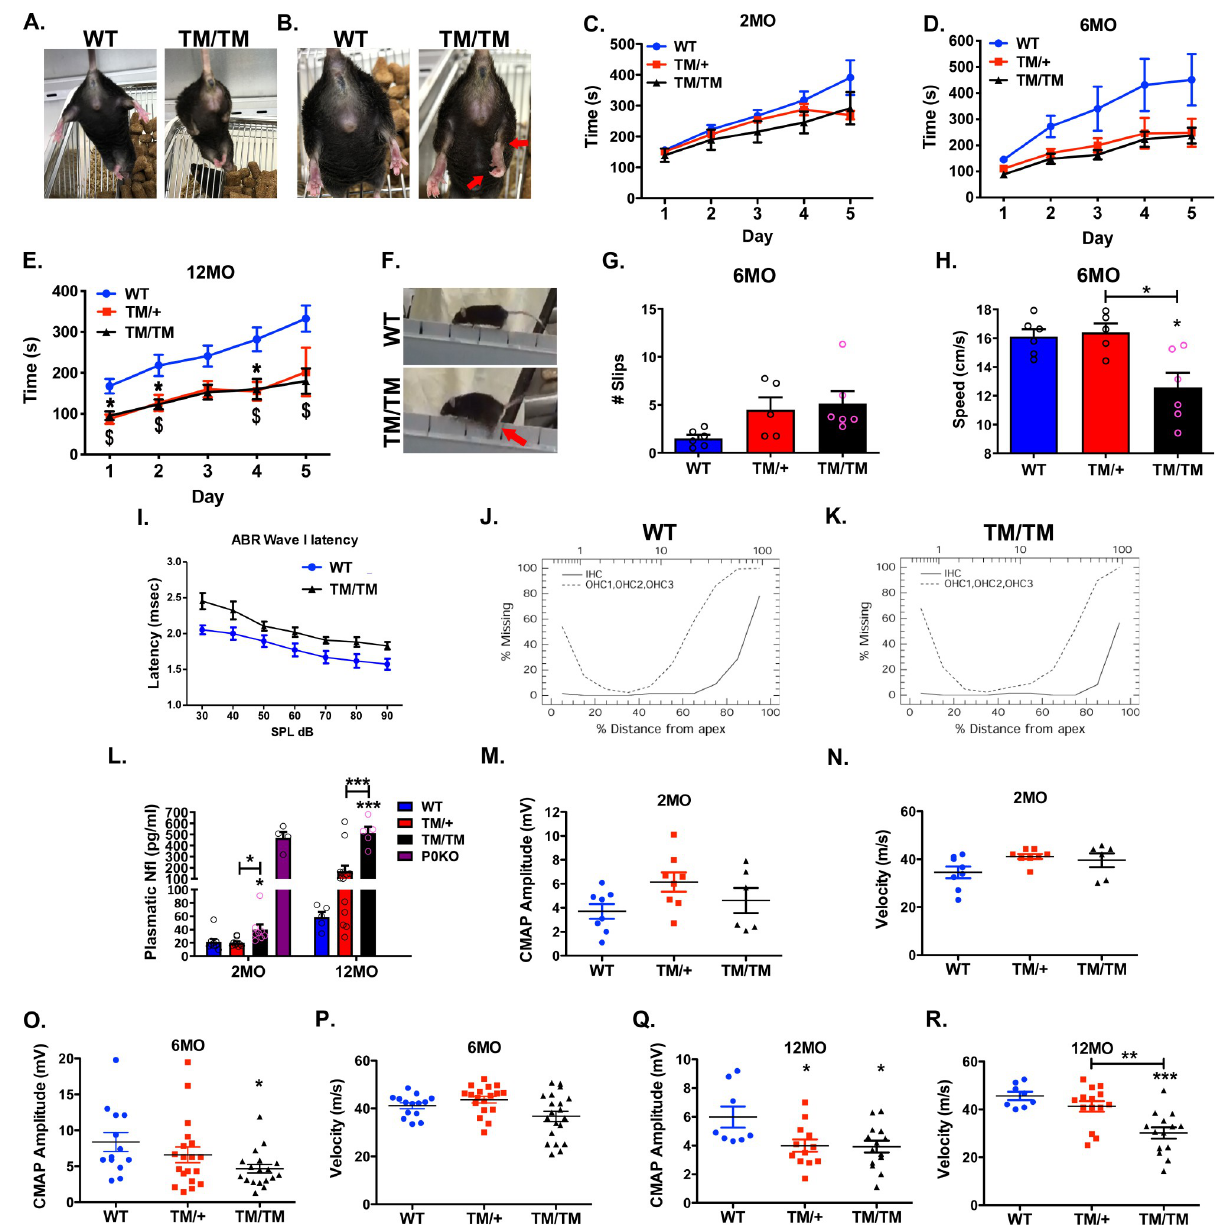
Fig 1. Clinical impairments in Mpz T124M mice. ( A and B ) External signs of neuropathy in 12-month-old Mpz T124M/T124M (TM/TM) mice. ( A ) Representative picture of clasping behavior. ( B ) Clawed hind paws and Achilles’ tendon retraction are indicated by arrows. ( C to G ) Locomotion is impaired in Mpz T124M mice. Accelerating rotarod test at 2 ( C ), 6 ( D ), and 12 ( E ) months of age. No differences were observed at 2 months of age. Compared to that of wild-type (WT) mice, the performance of Mpz T124M mice was worse at 6 months of age and significantly altered at 12. n (animals) � 4 per genotype. Two-way ANOVA [2 month old: Time: F (1.840, 38.64) = 30.54; P < 0.0001, Genotype F (2, 21) = 2.177; P = 0.1382; 6 month old: Time: F (1.723, 43.06) = 19.55, P < 0.0001; Genotype: F (2, 25) = 4.412; P = 0.0228; 12 month old: Time: F (1.291, 23.24) = 11.51; P = 0.0013; Genotype: F (2, 18) = 4.590; P = 0.0245] with Tuckey’s post hoc . � p < 0 . 05 : significant difference between WT and Mpz T124M/+ (TM/+); $ p < 0 . 05 : significant difference between WT and Mpz T124M/T124M . ( F to H ) Beam walking test at 6 months of age. ( F ) Representative pictures of beam walking test for WT and Mpz T124M/T124M mice. Arrow indicates a slip. Quantification of slips ( G ) and speed ( H ). n (animals) � 5 per genotype. One-way ANOVA [Slip: F (2, 14) = 3.430; P = 0.0613; Speed: F (2, 14) = 7.839; P = 0.0052]. ( I to K ) Auditory neuropathy in Mpz T124M mice. ( I ) ABR wave I latency measurements in WT and Mpz T124M/T124M mice at 11 months of age. Cochleograms of WT ( J ) and Mpz T124M/T124M ( K ) mice at 12 months of age. n (animals) � 4 per genotype. ( L ) Plasmatic neurofilament light (Nfl) concentrations in WT, Mpz T124M/+ , and Mpz T124M/T124M mice at 2 and 12 months of age. Plasma from 4-month-old P0 null mice was used as a positive control. n (animals) � 5 per genotype. One-way ANOVA [2 month old: F (2, 23) = 4.857; P = 0.0174; 12 month old: F (2, 21) = 14.83; P < 0.0001]. ( M to R ) Electrophysiological analysis. Amplitudes of compound muscle action potentials (CMAPs) and nerve conduction velocities (NCVs) were measured at 2 ( M and N ), 6 ( O and P ), and 12 ( Q and R ) months of age. n (nerves)